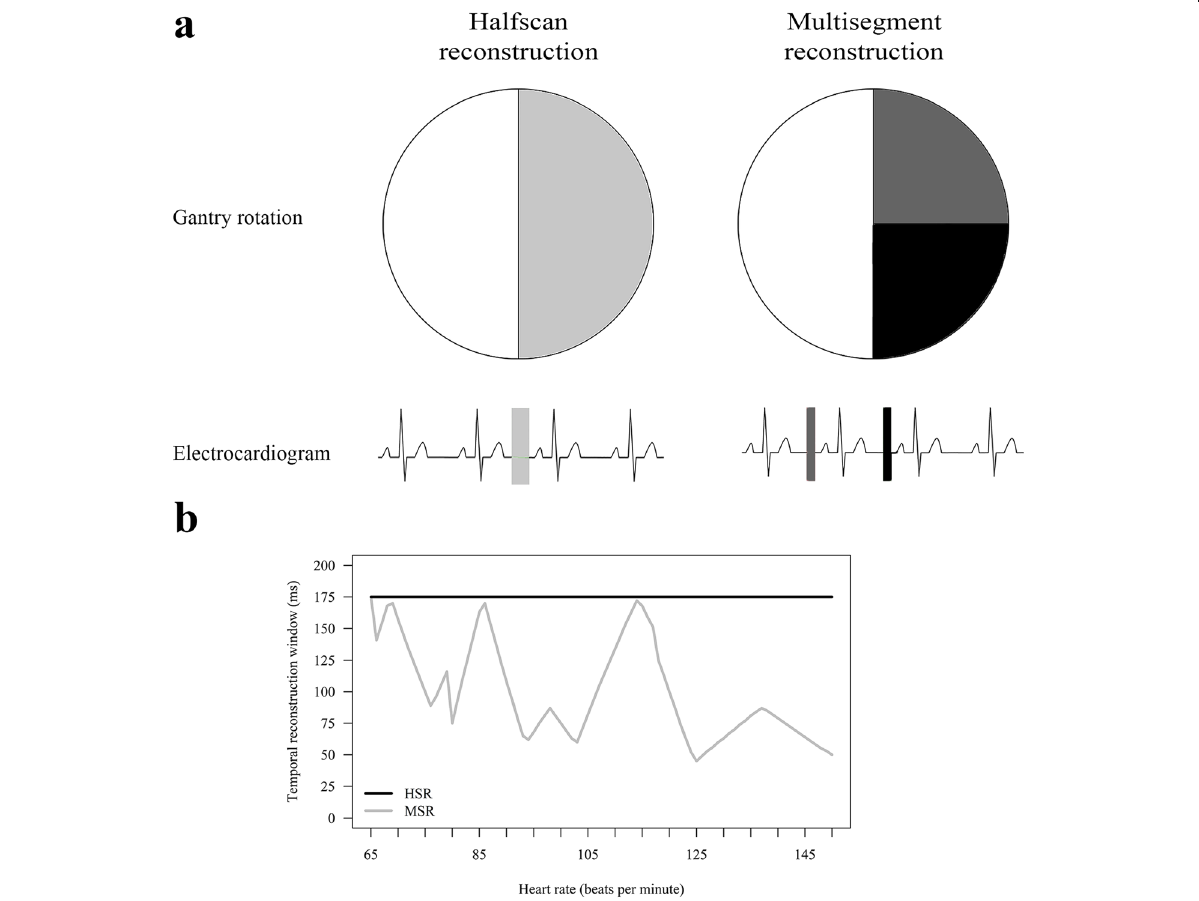
Fig. 2 Technical background for generating temporal reconstruction windows of MSR and HSR ( a ) and their dependency on patient ’ s heart rate ( b ). a The minimum partial scan raw data needed to reconstruct a volume require half a gantry rotation (+ fan angle). HSR uses partial scan raw data acquired within one heart beat (illustrated on the left in light grey) and consequently generates a per-segment temporal reconstruction window of half a gantry rotation. MSR uses partial scan raw data of approximately half a gantry rotation acquired in at least two successive heart beats, illustrated on the right for two segments in dark grey (segment one) and black (successive segment two). The resulting minimum per- segment temporal reconstruction window of MSR can be calculated as follows: Temporal reconstruction window = gantry rotation time / (2 × number of acquired segments). Thereby, acquiring more segments improves the per (heart)-segment temporal reconstruction window of MSR compared with HSR by up to the same factor as the number of segments acquired [see references [7 – 11]] at the cost of a higher radiation dose [see references [8, 12]]. b Line graphs showing the per-segment temporal reconstruction window of MSR and HSR depending on individual patient ’ s heart rate for a 350-ms gantry rotation time and acquisition of up to four segments. The temporal reconstruction window of HSR is always 175 ms, whereas the temporal reconstruction window of MSR ranges from 44 to 175 ms depending on heart rate. Data by courtesy of the equipment vendor. HSR Halfscan reconstruction, MSR Multisegment